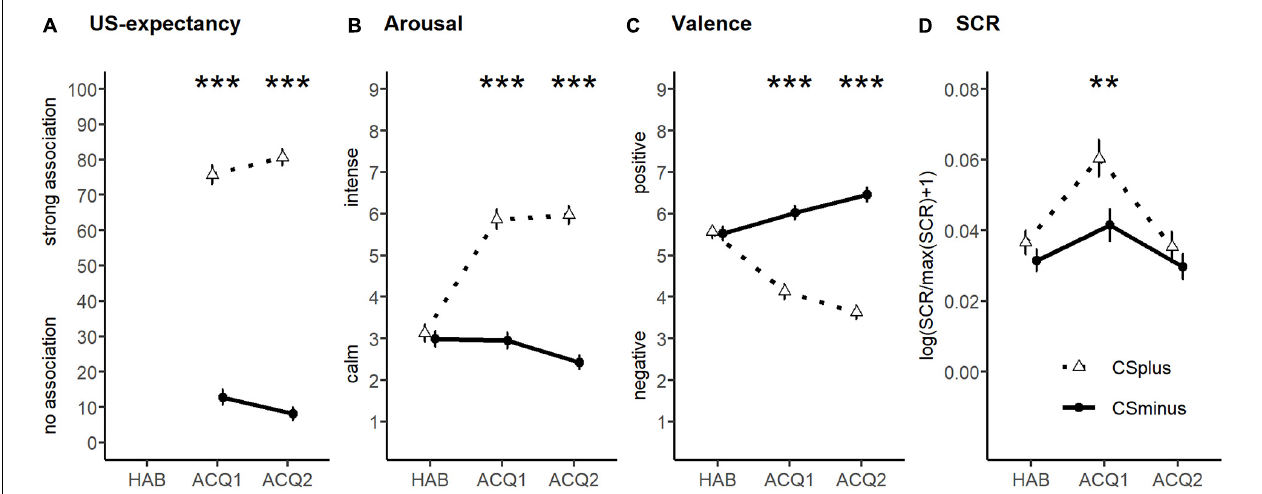
FIGURE 2 | Habituation and acquisition ratings of unconditioned stimulus (US) expectancy (A) , arousal (B) , and valence (C) as well as skin conductance responses (D) . Means (with SEs) of ratings and skin conductance responses (SCRs) are depicted for CS+ (white) and CS– (black) for habituation (HAB) for acquisition blocks (ACQ1, ACQ2). Acquisition of conditioned fear was successful as the CS+ vs. the CS– was rated as more likely predicting the US, more arousing, and more negatively valenced, and this elicited larger SCRs. Significance symbols indicate post hoc simple contrasts; *** p < 0.001, ** p <